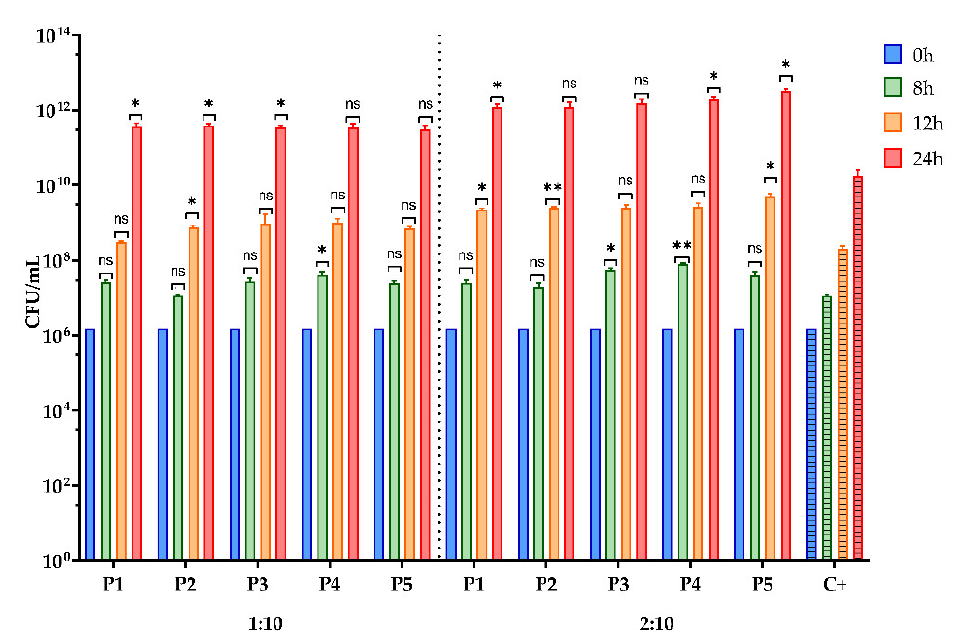
Figure 5. Graphic representation of CFU/mL values representing the influence of BPE on the bacterial growth of Lactobacillus rhamnosus MF9; (P1–P5)-BPE samples; (C+)- L. rhamnosus MF9 growth control . The prebiotic effect of BPE on L. rhamnosus MF9 growth was statistically analysed in one-way ANOVA and Dunnett’s multiple comparisons tests. The data is considered statistically significant. (ns—not significant; * p < 0.05; ** p < 0.007).